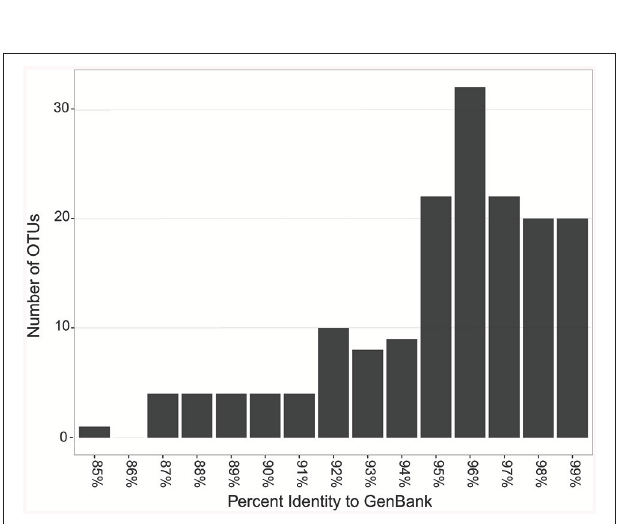
FIGURE 7 | Sequence identity based on BLAST comparisons to GenBank.